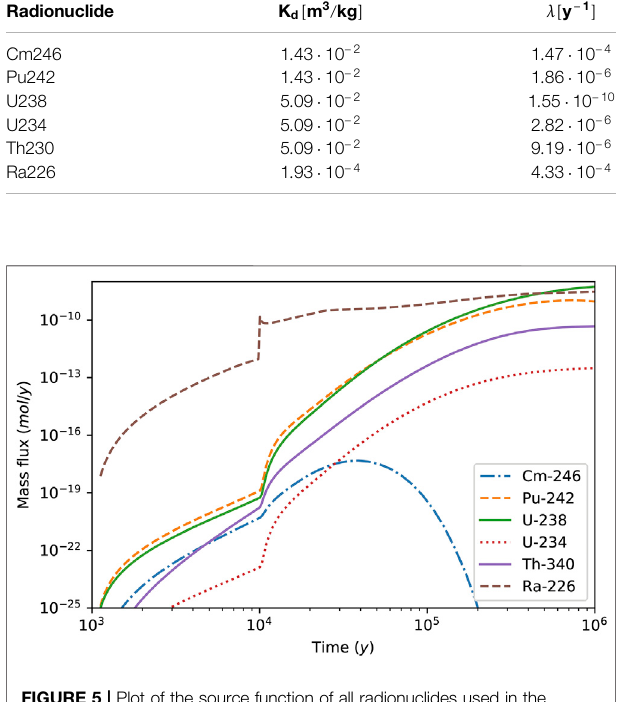
FIGURE 5 | Plot of the source function of all radionuclides used in the Decay Chain case .